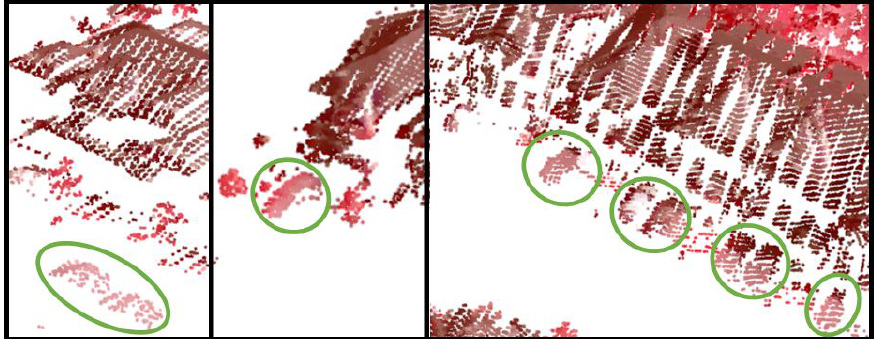
Figure 19. Radiometric characteristics of vehicles: green ovals represent vehicle locations—NIR, G, and B